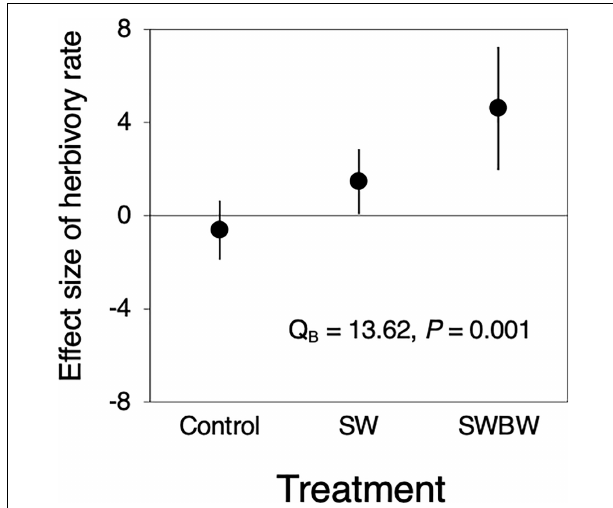
FIGURE 3 | Effect sizes (Cohen’s d ) of temporal variation (between 2010 and 2012) in herbivory rate in control trees (Control, n = 5), the soil-warmed trees (SW, n = 5), and soil and canopy branch-warmed trees (SWBW, n = 4). Positive effect size indicates that herbivory rate increased from 2010 to 2012 (before and after the warming experiment). Each dot indicates mean effect size. Each vertical line denotes 95% confidence interval (CI). The effect is significant if the 95% CI does not include zero. Significant Q B value indicates between-treatment heterogeneity.